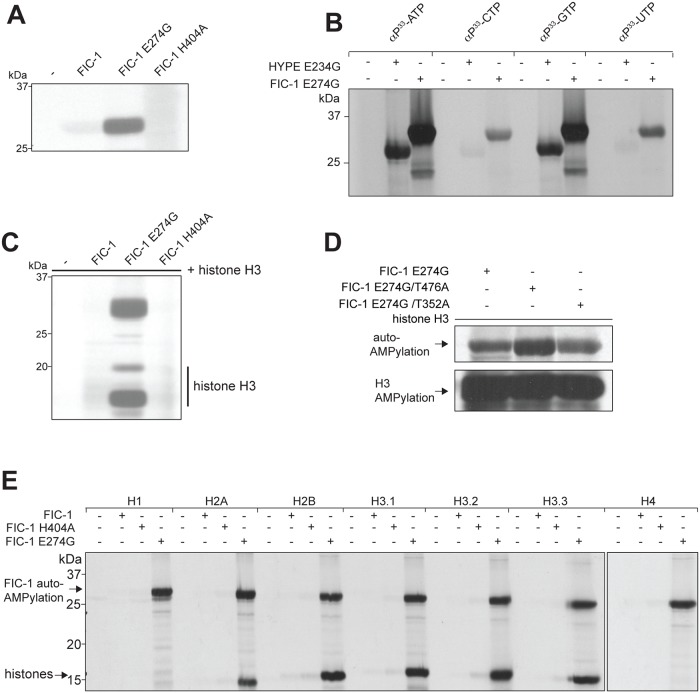
FIC-1 is an AMPylase.(A) FIC-1 exhibits auto-AMPylation activity: Recombinant FIC-1, FIC-1 E274G or FIC-1 H404A was incubated with α 33P-ATP for an hour and incorporation of label was assessed by SDS-PAGE and autoradiography. (B) FIC-1 accepts different nucleotide substrates: FIC-1 E274G or HYPE E234G were incubated with respective α 33P-labeled nucleotides for one hour at room temperature and sample autoradiography was assessed. (C) FIC-1 E274G AMPylates histone H3: Recombinant FIC-1, FIC-1 E274G or FIC-1 H404A was incubated with α 33P-ATP for an hour at which point histone H3 was added and the mixture was incubated for an additional hour. Incorporation of label was assessed by SDS-PAGE and autoradiography. (D) FIC-1 E274G/T476A and FIC-1 E274G/T352A are fully active: Recombinant FIC-1 E274G, FIC-1 E274G/T476A and FIC-1 E274G/T352A was incubated with α 33P-ATP for an hour at which point histone H3 was added and the mixture was incubated for an additional hour. Incorporation of label was assessed by SDS-PAGE and autoradiography. (E) FIC-1 AMPylates core histones H2 and H3 but not H4: Recombinant FIC-1, FIC-1 E274G or FIC-1 H404A was incubated with α 33P-ATP for an hour at which point purified histone substrates were added and the mixture was incubated for an additional hour. Incorporation of label was assessed by SDS-PAGE and autoradiography.